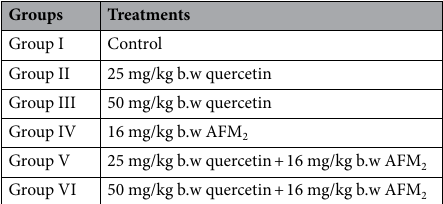
Table 1. Experimental groups and